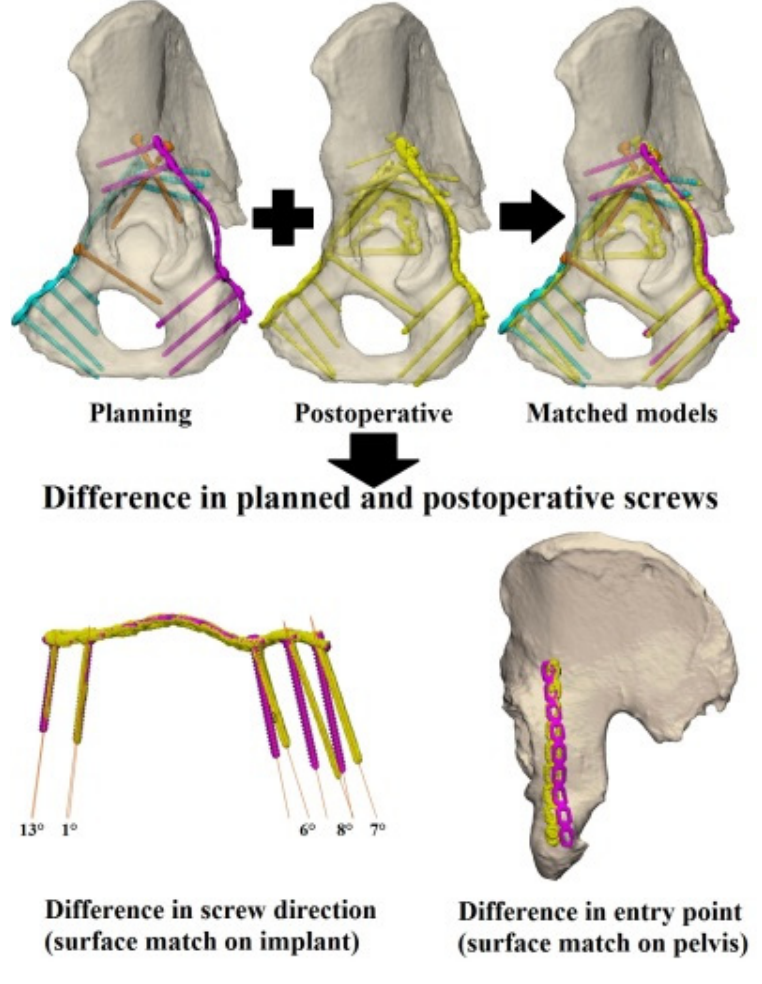
Figure 5. Postoperative analysis. The planned screw directions and positions (pink for posterior, blue for anterior, and orange for the infra-acetabular and column screws) are matched with the postoperative actual screw directions and positions (in yellow). The difference in the screw direction (lower left) and screw entry point (lower right) were measured.